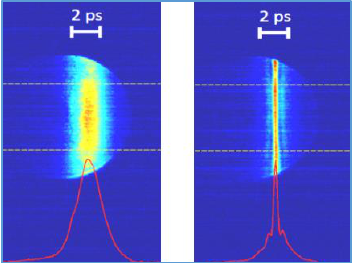
Fig. 2. AC images obtained at the 450 mJ/cm 2 incident laser peak fluence without post-compression (left) and with a two- element KCl+BaF 2 compressor (right).